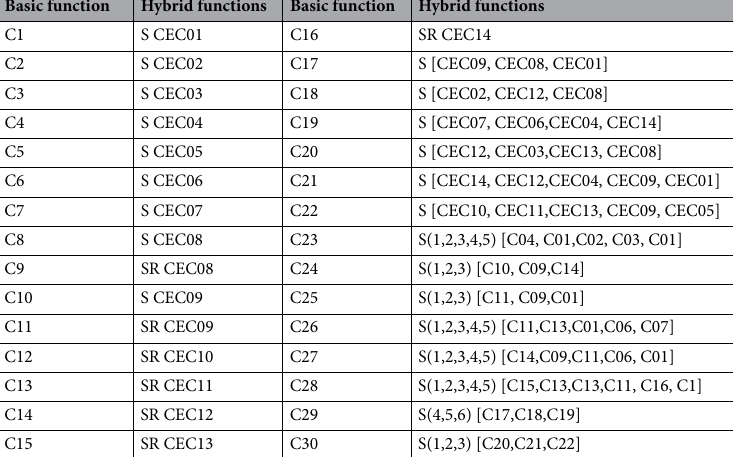
Table 3. Some IEEE CEC functions applied to evaluate the IESOA method. Note: Shift is (S), and Shift Rotate (SR).